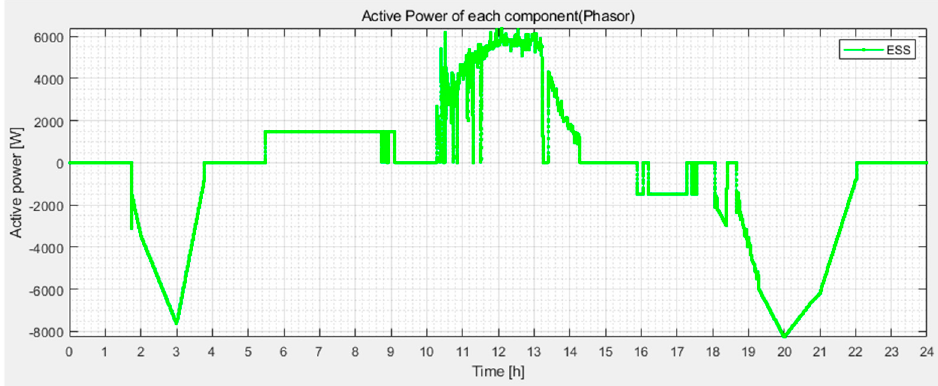
Figure 19. Control capacity by the ESS operation.